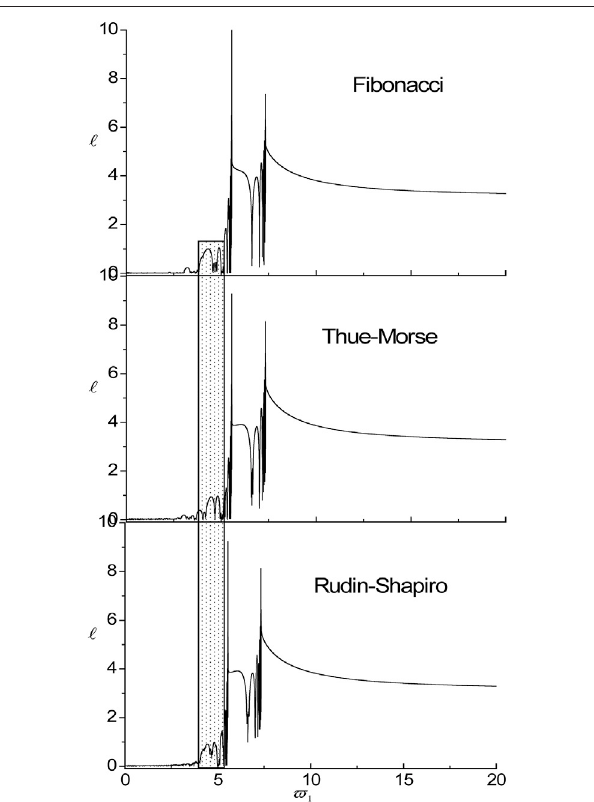
FIGURE6| ThelocalizationfactorsoftheSHwavepropagatingnormally in the nanoscale aperiodic Thue-Morse sequences consisting of ZrO 2 /Cu, HfO 2 /ZrO 2 and Cu/Al for τ 1 = τ 2 = 0.18.